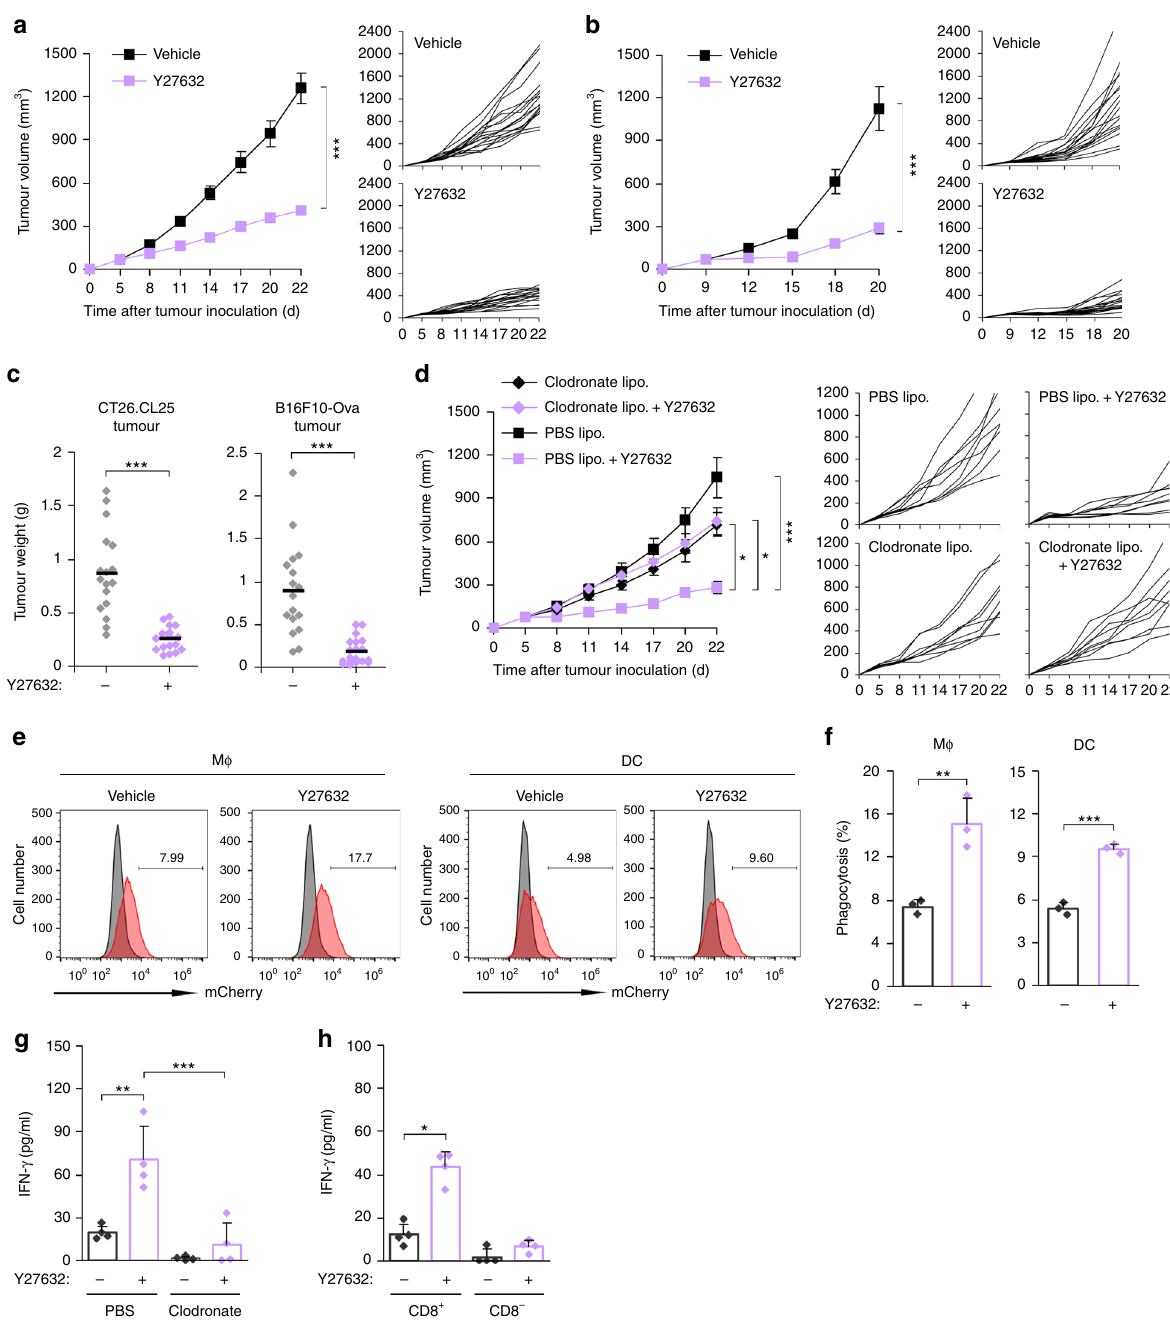
Fig. 2 Phagocytes are crucial to antitumour effect of ROCK blockade. a – c CT26.CL25 tumour-bearing BALB/c mice ( a ) and B16F10-Ova tumour-bearing C57BL/6 mice ( b ) were injected (i.v.) with Y27632 (10 mg kg − 1 ) or vehicle (PBS). Tumour dimensions were measured at the indicated times using calipers and tumour volume was calculated (mm 3 ). Data are presented as means ± s.e.m. (left panels) and tumour growth curves of individual mice (right panels) (CT26.CL25 model, n = 17; B16F10-Ova model, n = 17 – 19). c Tumour weights in individual mice were analysed at the end of experiments. Each dot represents tumour weight of individual mice. Bars indicate mean values. d – g CT26.CL25-mCherry tumour-bearing BALB/c mice were injected (i.v.) with Y27632 (10 mg kg − 1 ) together with clodronate liposomes or PBS liposomes as described in Supplementary Fig. 6c. d Tumour volume was measured at the indicated time. Data are presented as means ± s.e.m. (left panel) and tumour growth curves of individual mice (right panels) ( n = 9). e , f For the PBS liposomes-treated group, F4/80 + macrophages or CD11c + DCs were isolated from tumours, and the percentage of cells harbouring mCherry + tumour cells was determined by fl ow cytometry. e Representative fl ow cytometry plots. The grey peaks represent mCherry levels in macrophages and DCs from CT26.CL25 tumour-bearing mice (mCherry-negative tumour). f Data are presented as means± s.d. ( n = 3). g At 22 days after tumour inoculation, single- cell suspensions from tumour-draining LNs were stimulated with β -gal-derived peptide for 48 h, and secreted IFN- γ was measured by ELISA. Data are presented as means ± s.d. ( n = 4). h At 22 days after tumour inoculation, CD8 + and CD8 − cells were isolated from tumour-draining LNs and stimulated with β -gal-derived peptide for 48 h, and secreted IFN- γ was measured by ELISA. Data are presented as means ± s.d. ( n = 4). * P < 0.05, ** P < 0.01, *** P < 0.001; signi fi cance determined by unpaired Student ’ s t test ( a , f ), Mann – Whitney test ( b , c ) or one-way ANOVA with Tukey ’ s post hoc test ( d , g , h